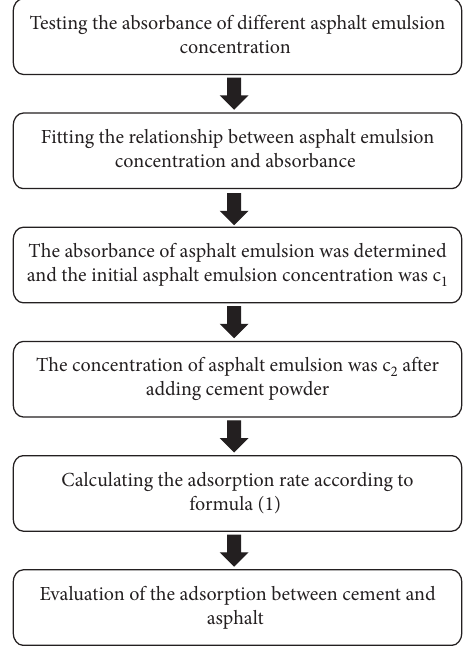
Figure 4: The process for the adsorption test.